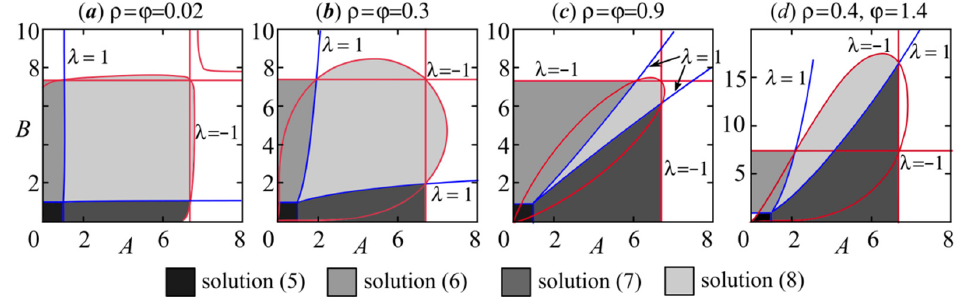
Figure 4. Stability domains of fixed points (5)–(8) for different values of ρ and φ with φρ < 1.